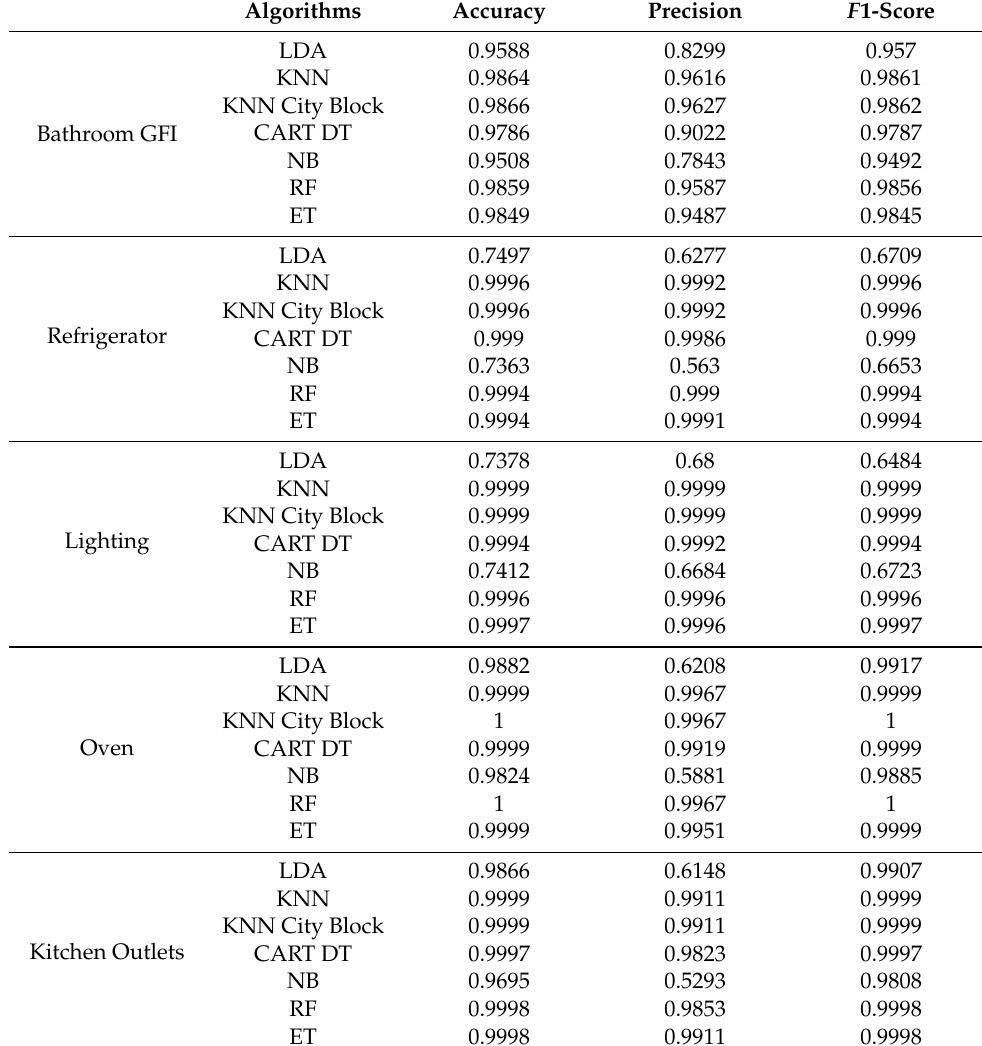
Table 6. Per appliance performance